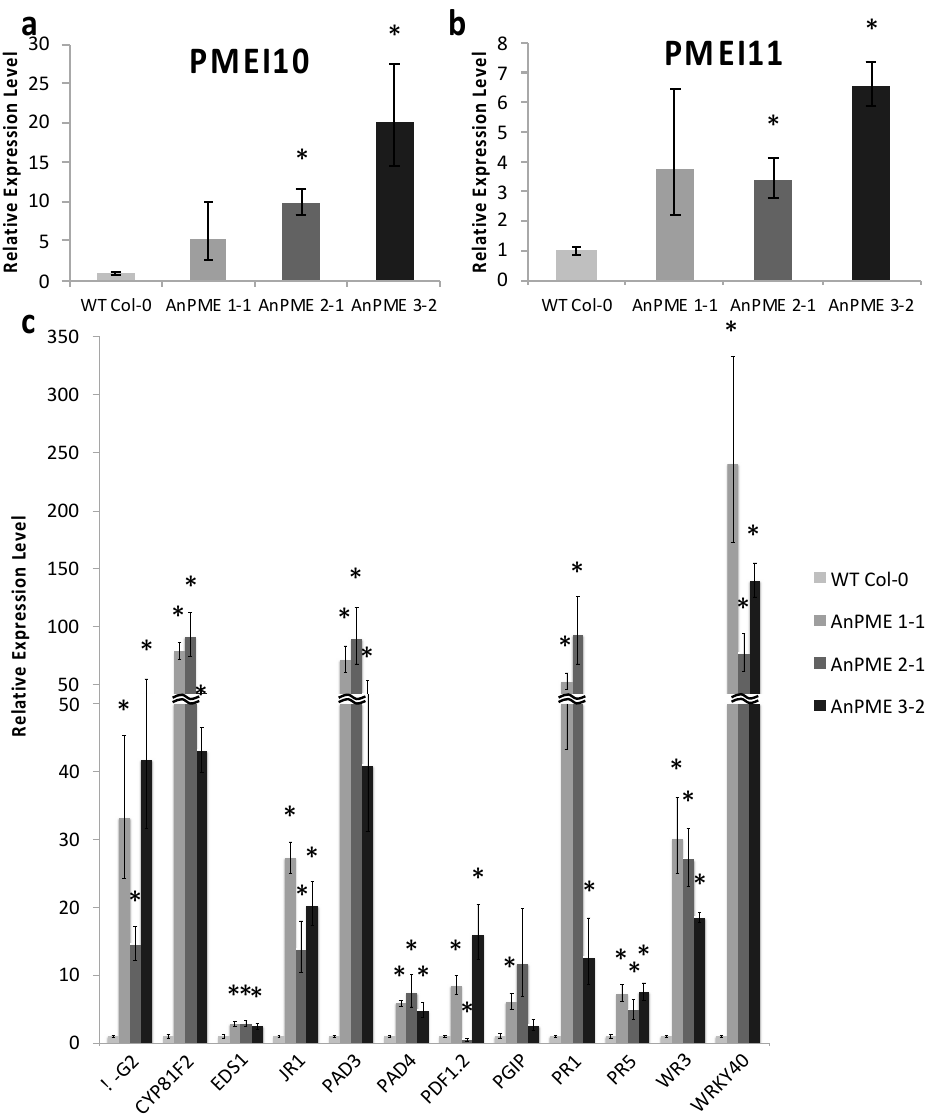
Figure 5. RT-qPCR of defense response genes. ( a , b ) Expression of PMEI10 and PMEI11 in plants grown under normal conditions ( n = 5); ( c ) Expression of defense response genes grown under normal conditions ( n = 5). Error bars represent standard deviation. Asterisks indicate statistical significance ( p < 0.05, one-way ANOVA).